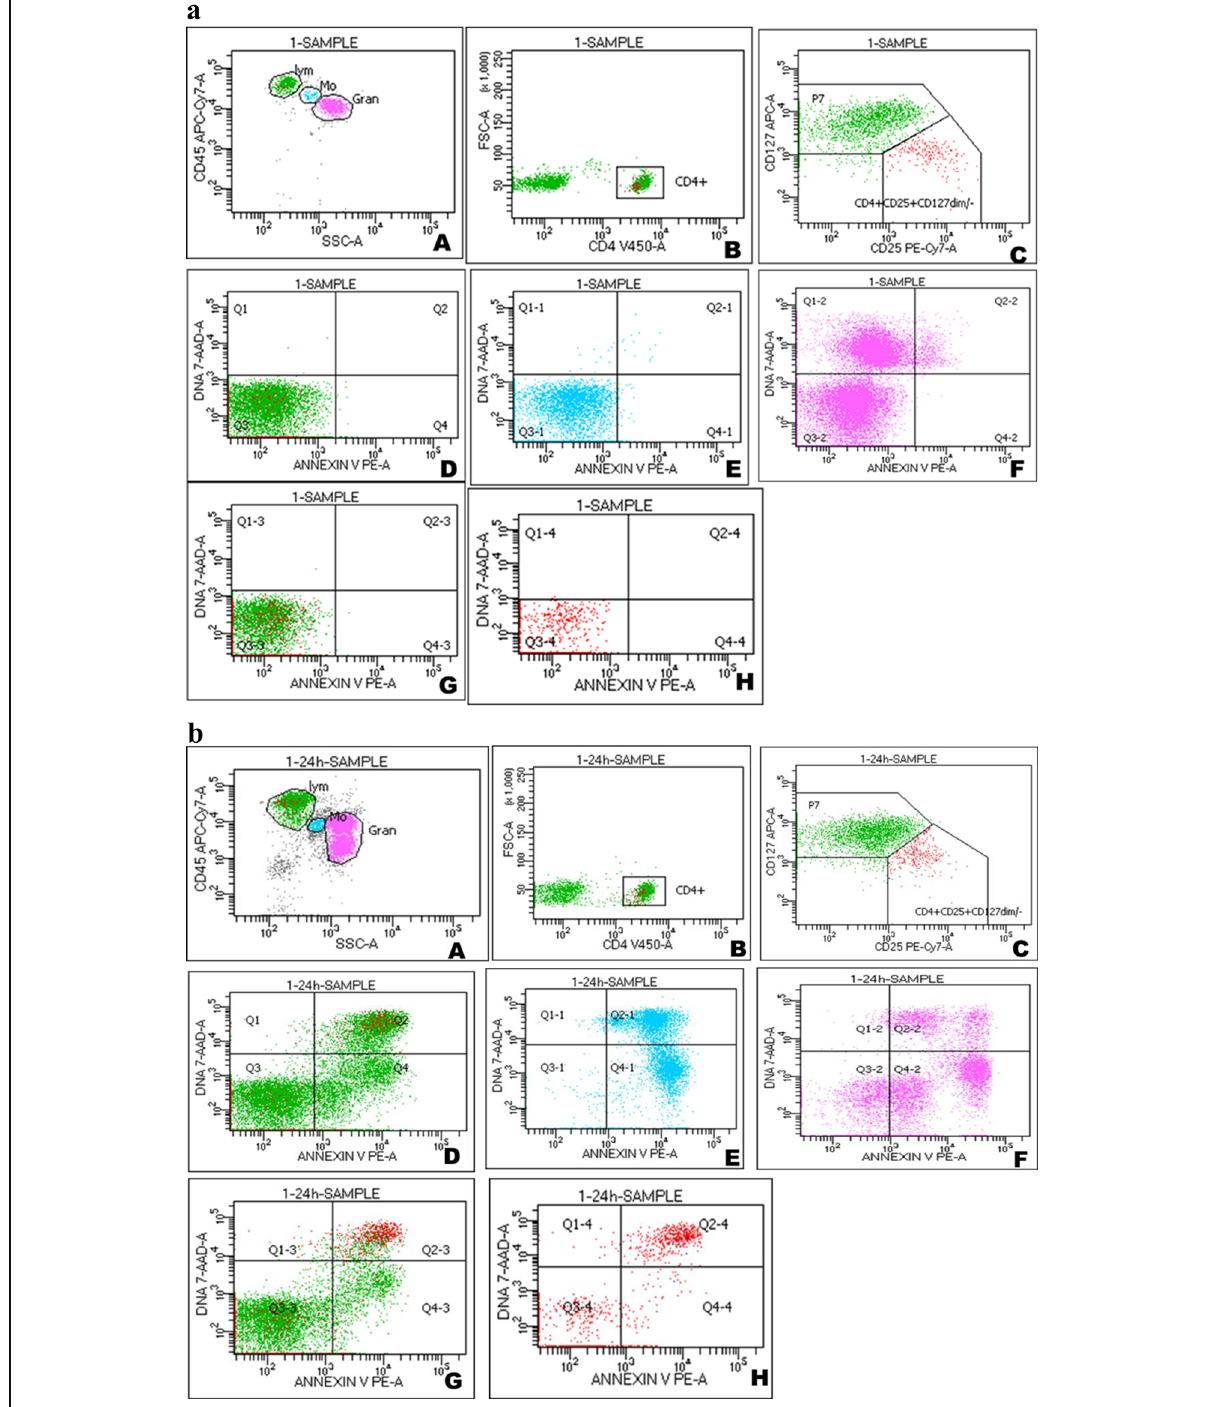
Fig. 5 a Apoptosis of lymphocyte, monocytes, granulocyte, CD4+ and Treg at 0h. A= CD45 APC-cy7-A Vs SSC-A, B=FSC-A Vs CD4 V450-A, C= CD127 APC-A Vs CD25 PECy7-A, D= Apoptosis of Lymphocytes, E= Apoptosis of Monocytes, F= Apoptosis of Granulocytes, G=Apoptosis of CD4+, H= Apoptosis of Treg. b Apoptosis of lymphocyte, monocytes, granulocyte, CD4+ and Treg at 24 hrs. A= CD45 APC-cy7-A Vs SSC-A, B=FSC-A Vs CD4 V450-A, C= CD127 APC-A Vs CD25 PECy7-A, D= Apoptosis of Lymphocytes, E= Apoptosis of Monocytes, F= Apoptosis of Granulocytes, G=Apoptosis of CD4+, H= Apoptosis of